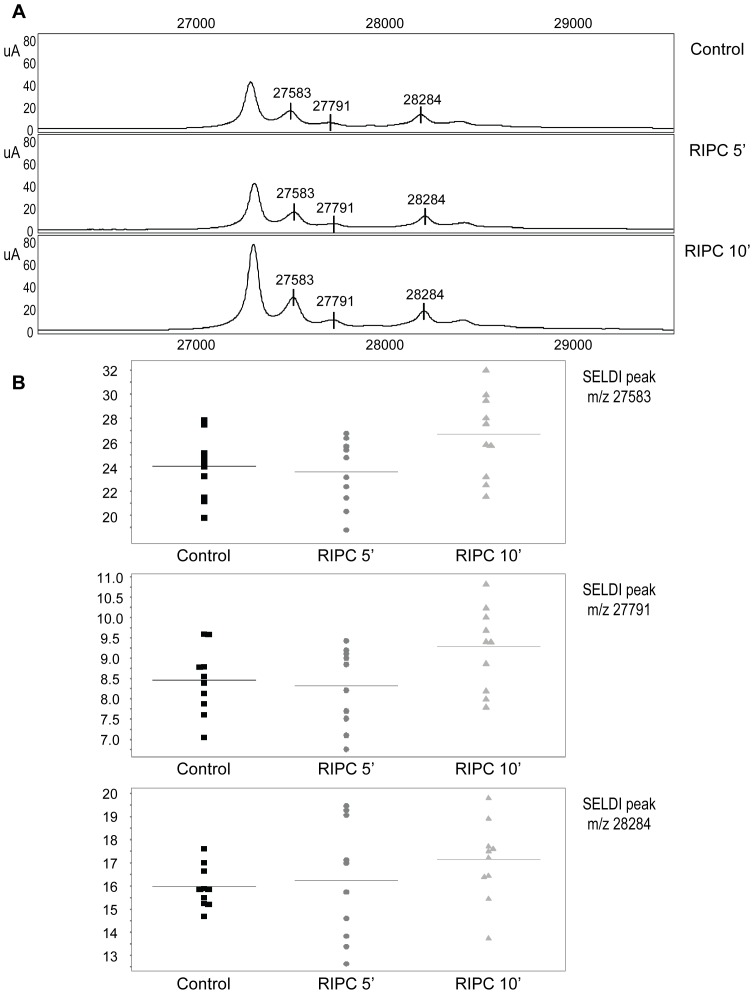
Illustration of protein spectra and m/z means of cases and controls.(A) Representative SELDI-TOF-MS protein spectra of plasma sample from one Control, one RIPC (remote ischemic preconditioning) 5′, and one RIPC 10′ rat. Results are presented as intensities of SELDI-TOF reading (arbitrary units). The 27583, 27791, and 28284 m/z peaks were found to be differentially expressed on the CM10 array as calculated by the Mann-Whitney test. (B) Scattergram showing the significant differences in intensity of 27583, 27791, and 28284 m/z peaks in plasma samples derived from Control, RIPC 5′, and RIPC 10′ rats. The continuous line represents the mean, and dots represent each individual rat (n = 10 in each group). Detailed p-value data for comparison between the three groups is indicated in Table 1.